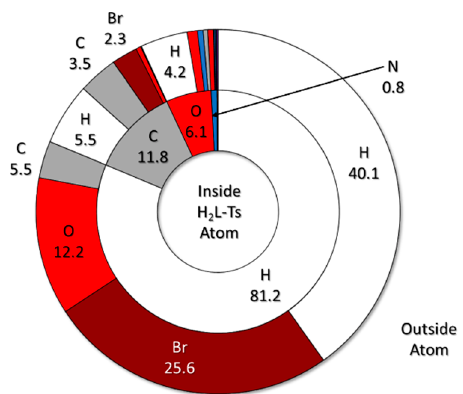
Figure 8. Overview of (H 2 L-Ts) 2+ Hirshfeld surface percentage composition (complete data in tabular form are found in Table S2). Inner ring: internal composition of Hirshfeld surface, i.e., a depiction of (H 2 L-Ts) 2+ molecular surface; outer ring: closest outer atom, i.e., atom in contact with (H 2 L-Ts) 2+ Hirshfeld surface. Colour code: white: H; grey: C; blue: N; red: O; yellow: S; brown: Br.